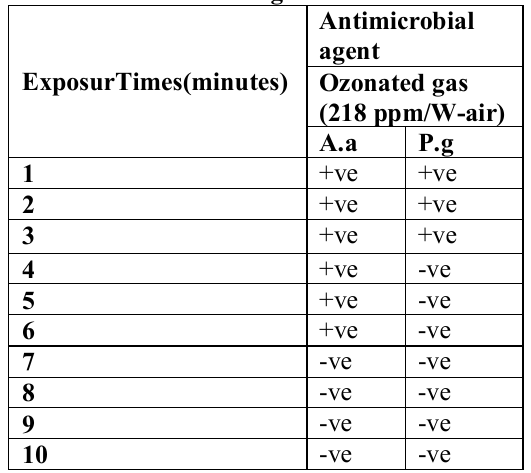
Table 1: Efficiency of ozonated gas at different exposure times onA.a and P.g.